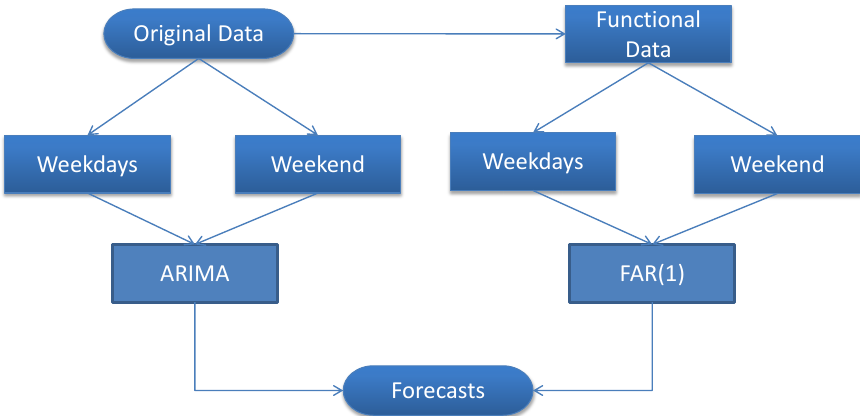
Figure 1. Flowchart of the proposed modeling framework.